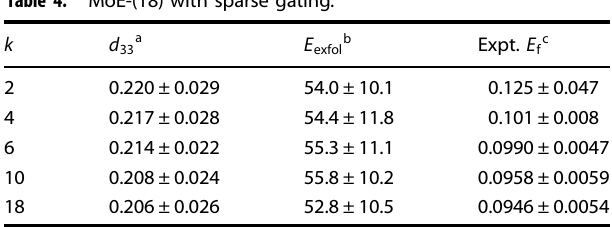
Fig. 5 Heatmap of learned probability scores assigned to each feature extractor by our mixture of experts framework. Source tasks are ordered left to right from smallest to largest dataset size. Contrary to the heuristic of transferring from the largest source task, our MoE framework did not usually assign the largest score to the largest source task. Instead, the model often assigned scores which were physically intuitive. Table 4. MoE-(18) with sparse